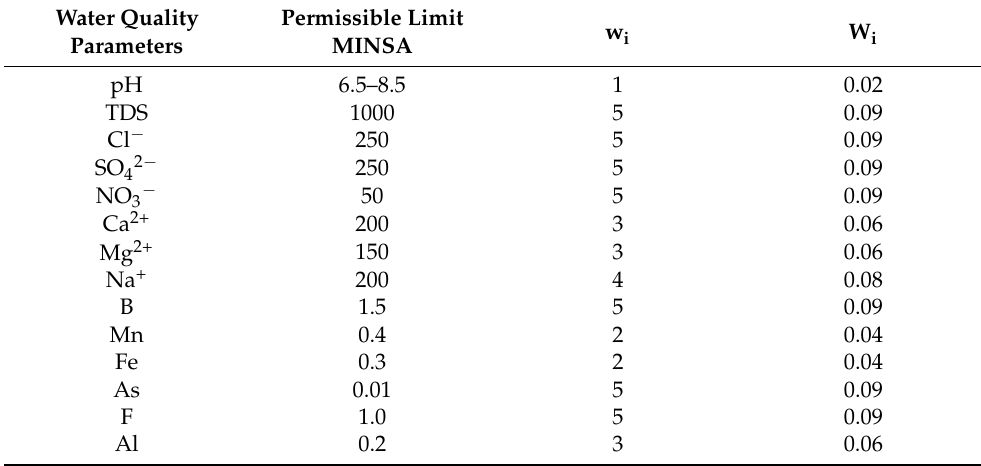
Table 4. Assigned weights for quality